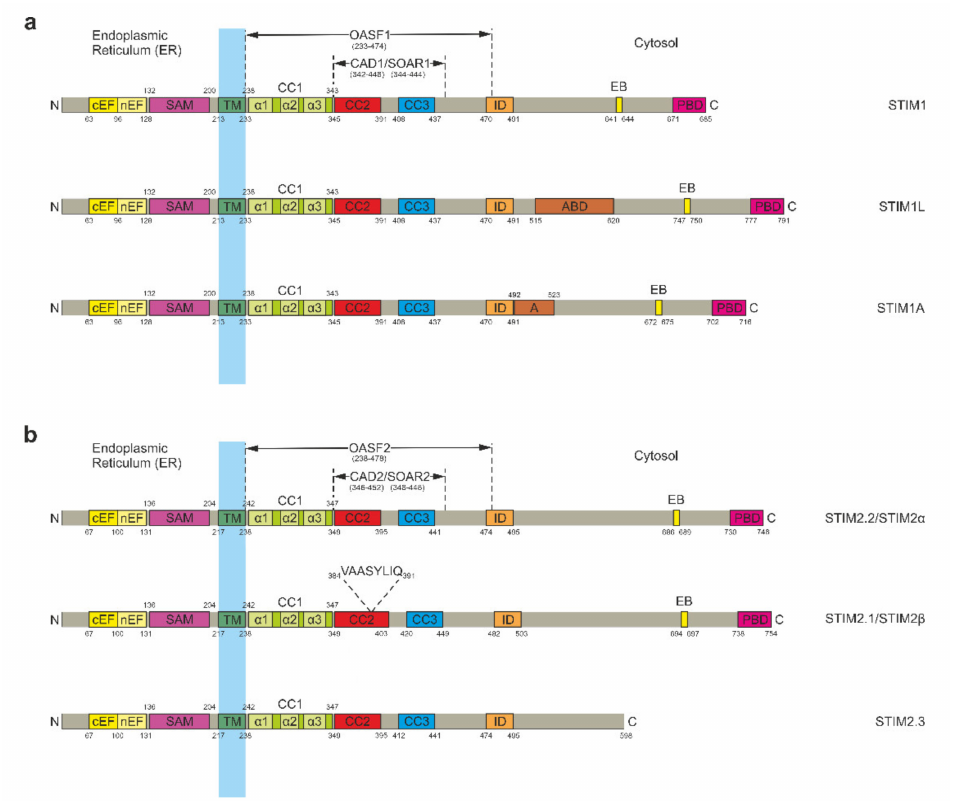
Figure 1. Domain structure of stromal interaction molecule (STIM) proteins. ( a ) Primary structure of STIM1 and its isoforms STIM1 Long (STIM1L) and STIM1A. Functionally relevant domains within the endoplasmic reticulum (ER) luminal portion include the canonical (cEF) and noncanonical (nEF) EF hands as well as the sterile alpha motif (SAM). Downstream of the transmembrane domain (TM), the cytosolic portion contains three coiled coil (CC) domains commonly known as CC1, CC2, and CC3 with CC1 being further subdivided into α 1, α 2, and α 3. The C-terminal fragment spanning all three CC domains is termed Orai-activating small fragment (OASF). Another fragment comprising CC2 and CC3 is named CRAC-activating domain (CAD) or STIM-Orai-activating region (SOAR). Further C-terminal domains include the inactivation domain (ID or ID-STIM), the microtubule end-binding domain (EB), and the polybasic domain (PBD) at the outermost C-terminus. STIM1L and STIM1A feature the same general structure but each harbor an additional C-terminal domain inserted downstream of the ID domain by alternative splicing. STIM1L thereby includes an actin-binding domain (ABD) while STIM1A possesses an insert designated as domain A. ( b ) Primary structure of STIM2.2/STIM2 α and its isoforms STIM2.1/STIM2 β and STIM2.3. For reasons of simplicity, the 87 amino acid N-terminal signal peptide insertion of STIM2.2 and its isoforms was omitted from this display [43–45]. Due to the high degree of similarity between STIM1 and STIM2.2, their functional domains are essentially equivalent. Alternative splicing leads to inclusion of a small 8 amino acid insert (VAASYLIQ) within the CC2 domain of STIM2.1 and to an upstream end of translation in case of STIM2.3, shortening the protein by 148 amino acids. Otherwise, both STIM2.1 and STIM2.3 correspond to